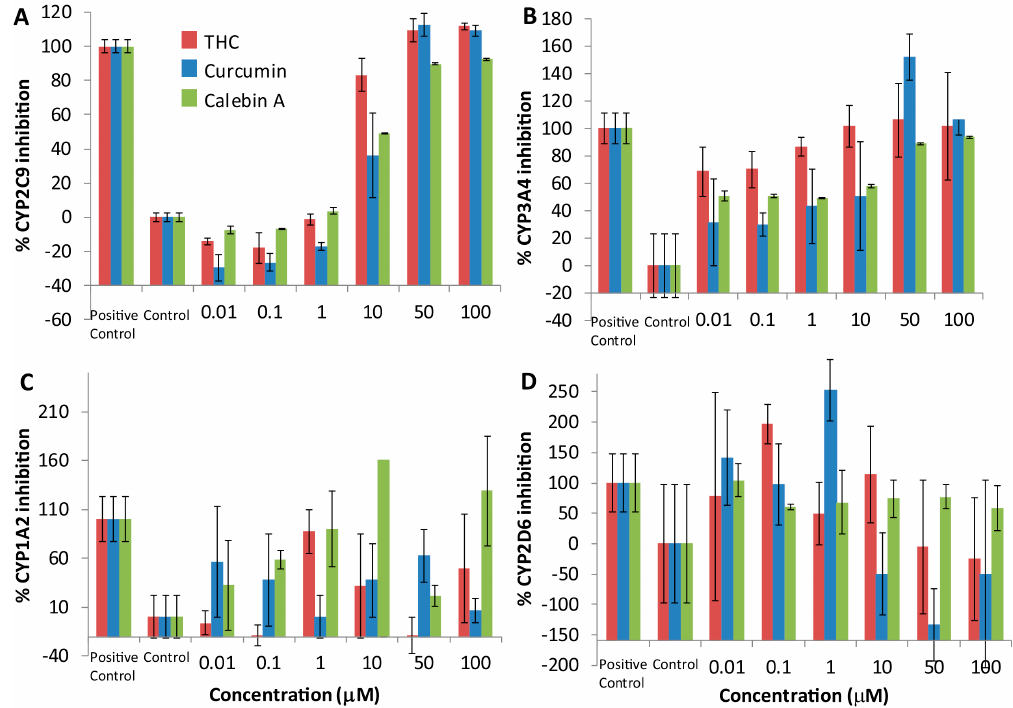
Figure 4. The inhibition of selected common drug-metabolizing enzymes by curcuminoids. Displayed are graphs showing the inhibition of CYP 2C9 ( A ); CYP3A4 ( B ); CYP1A2 ( C ); and CYP 2D6 ( D ) by THC, curcumin and calebin-A with solvent and positive controls using commercial assay kits.